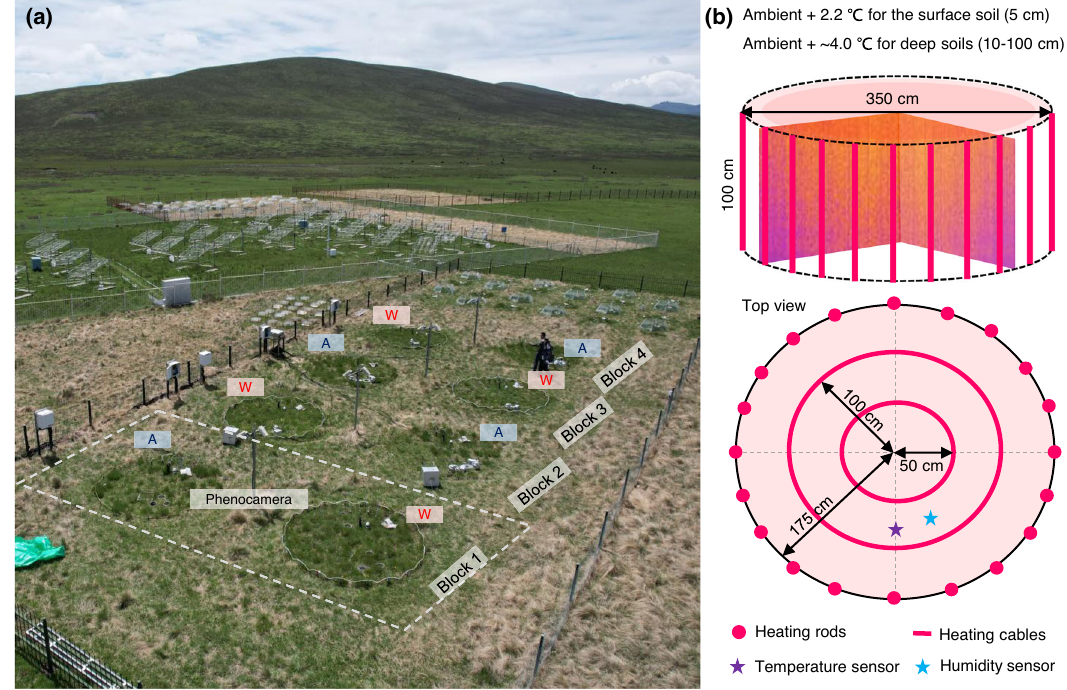
Fig. 1 | Experimental set-up. a Aerial view of the whole-soil-pro fi le warming experiment conducted at the Haibei Alpine Grassland Ecosystem Research Station on the Qinghai-Tibetan Plateau, China. The experiment involved two climate treatments, namely warming vs. ambient temperature, arranged into eight plots, with four replicates for each treatment. Each plot was equipped with a PhenoCa- mera. b A three-dimensional layout diagram depicting the arrangement of 20